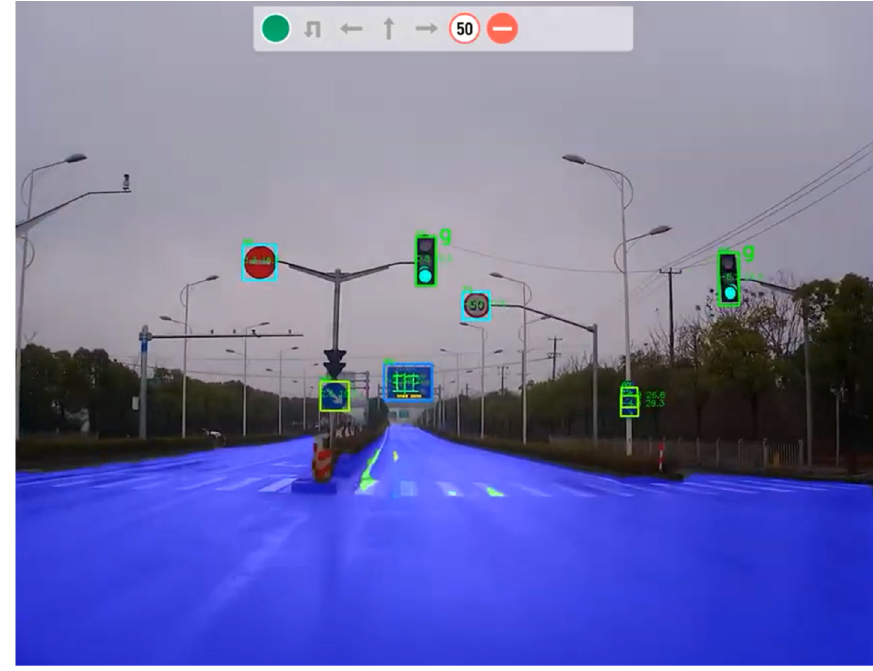
Figure 11. TSR algorithm running on KITTI dataset—example 2.